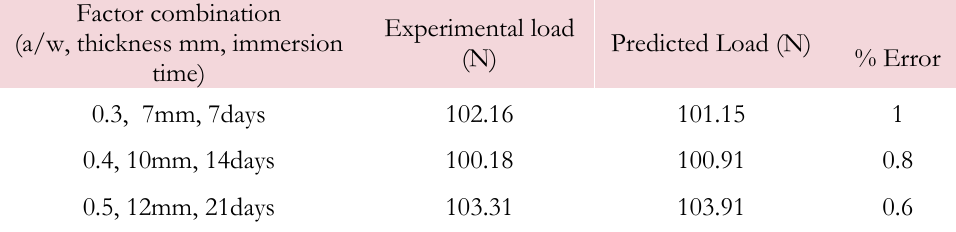
Table 10: Confirmation Test table for Fracture toughness MPa